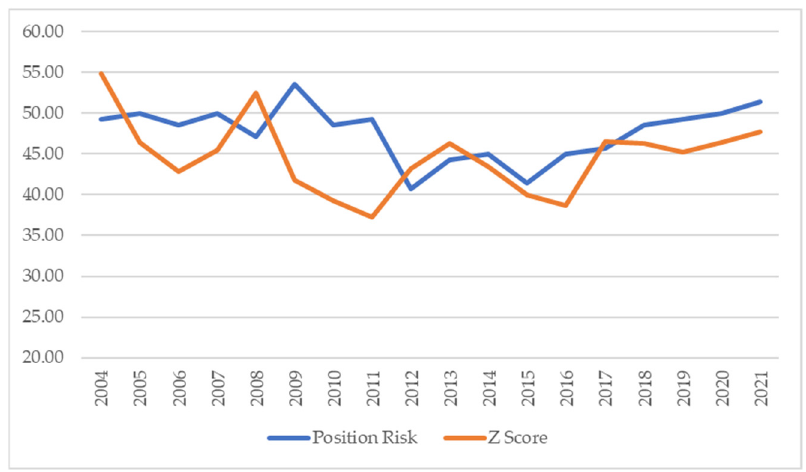
Figure 3. Risk Scores.